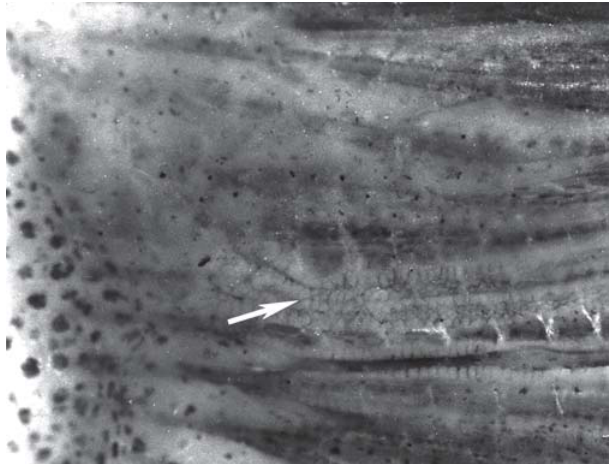
Fig. 31. Mimagoniates inequalis , male, MZUSP 75515, 33.1 mm SL; central region of caudal-fin base and fin showing beaded tissue indicated by arrow along borders of principal caudal-fin rays 11-14. Upper cluster of beaded tissue primarily positioned along borders of rays 11 and 12, rays that border groove of primitive caudal